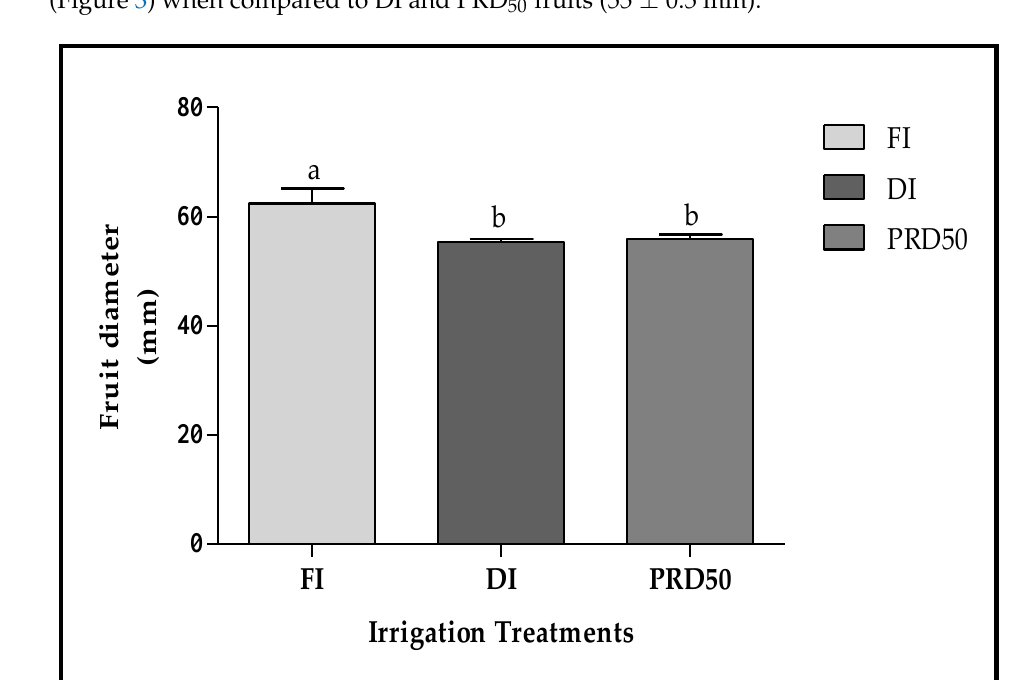
Figure 3. Fruit diameter (±SD) of Flordastar peaches grown under FI, DI and PRD 50 irrigation treatments, expressed in (mm). Different letters refer to significant differences tested using Duncan’s multiple range test ( p < 0.05).